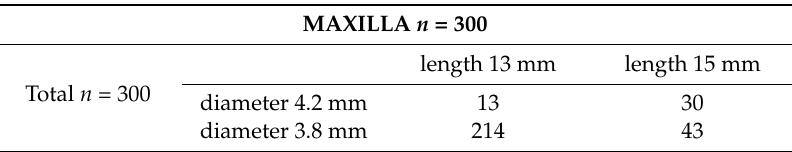
Table 1. Implant diameters and lengths.